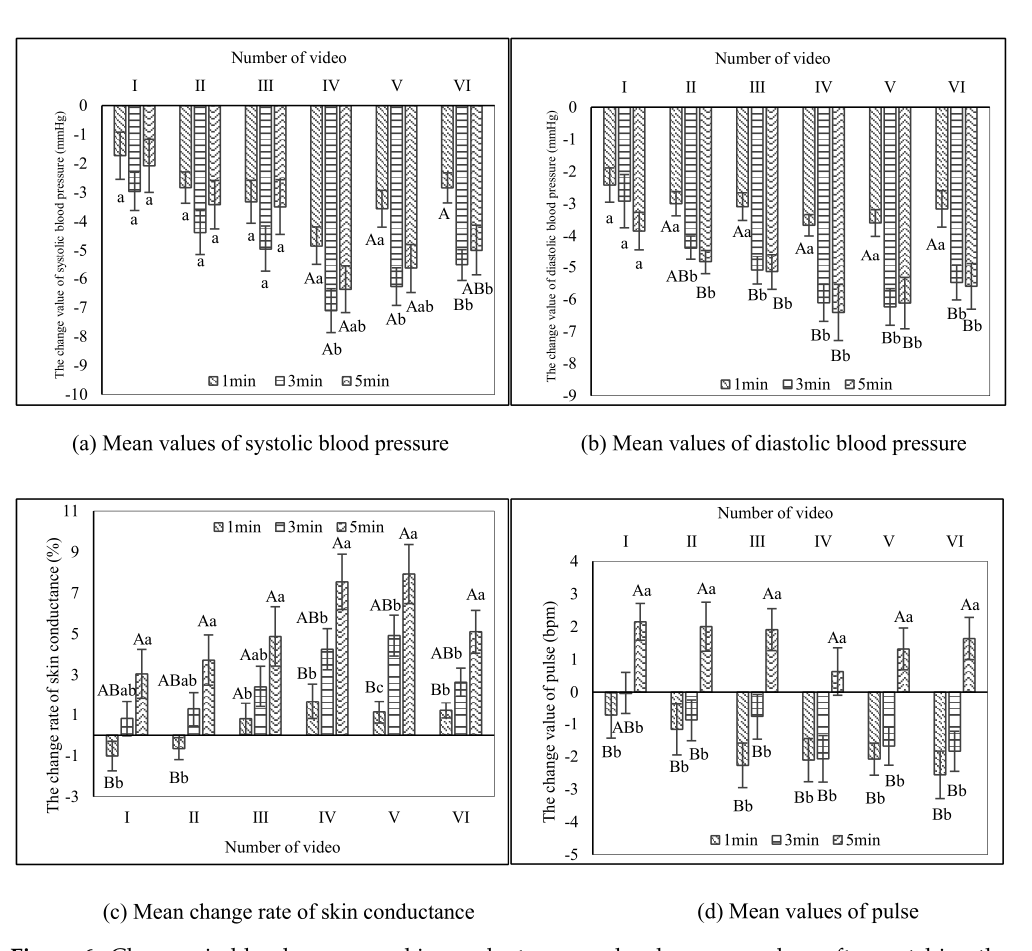
Figure 6. Changes in blood pressure, skin conductance, and pulse mean values after watching the urban bamboo forest videos of different durations ( n = 30; mean ± standard error). Different capital letters represent extremely significant differences ( p < 0.01) between 1, 3, and 5 min in each site for the blood pressure, skin conductance, and pulse indicators. Different lowercase letters represent significant differences ( p < 0.05) between 1, 3, and 5 min in each site for the blood pressure, skin conductance, and pulse indicators. The same letters indicate no significant differences between 1, 3, and 5 min in each video. The zero point represents the value measured after participants watched the blank video.